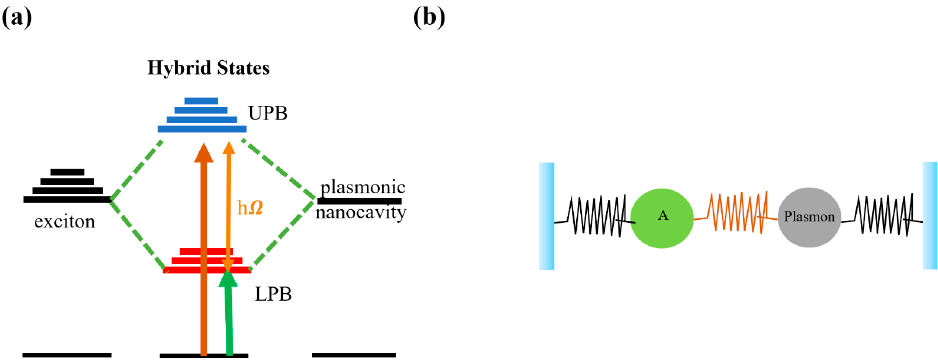
Figure 1. ( a ) Schematic of the energy states of the double coupling of the plasmon mode with the exciton. ( b ) Strong coupling regime illustrated by two coupled oscillators. Adapted with permission from Ref. [74]. Copyright 2010 AIP Publishing.